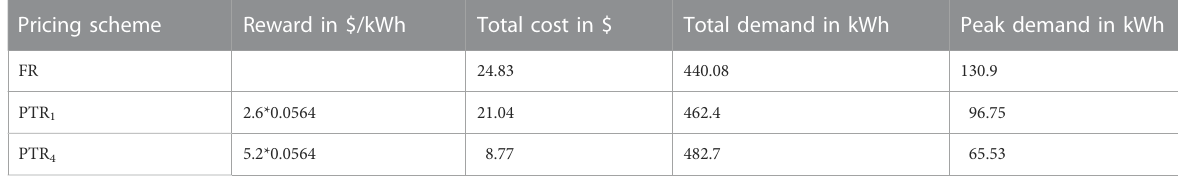
TABLE 7 Doubling of the rebate scenario. Pricing scheme